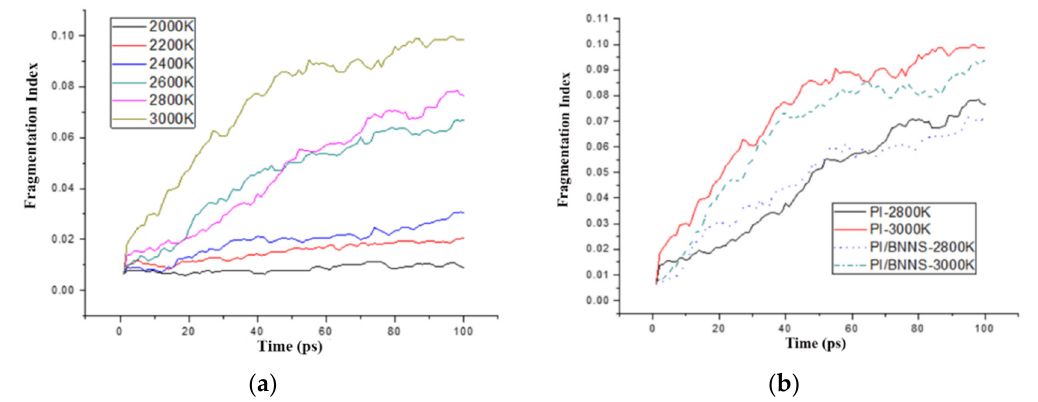
Figure 7. ( a ) PI neat fragmentation index after pyrolysis at high temperatures; ( b ) PI neat and PI/BNNS fragmentation index after pyrolysis at high temperatures.